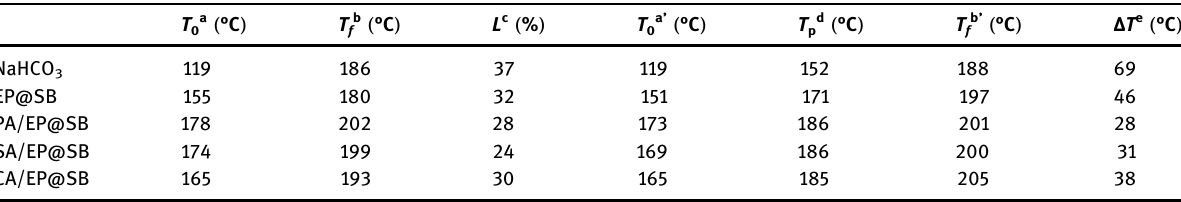
Table 1: TGA data and thermodynamic parameters of the SB - based